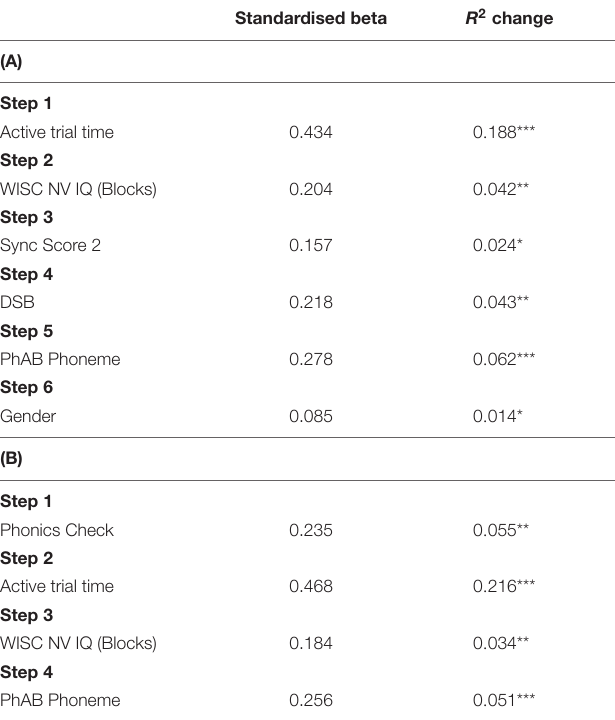
TABLE 4 | Unique variance ( R 2 change) in progression through GG Rime explained by gender (A) and when controlling for the autoregressor Phonics Check (B)